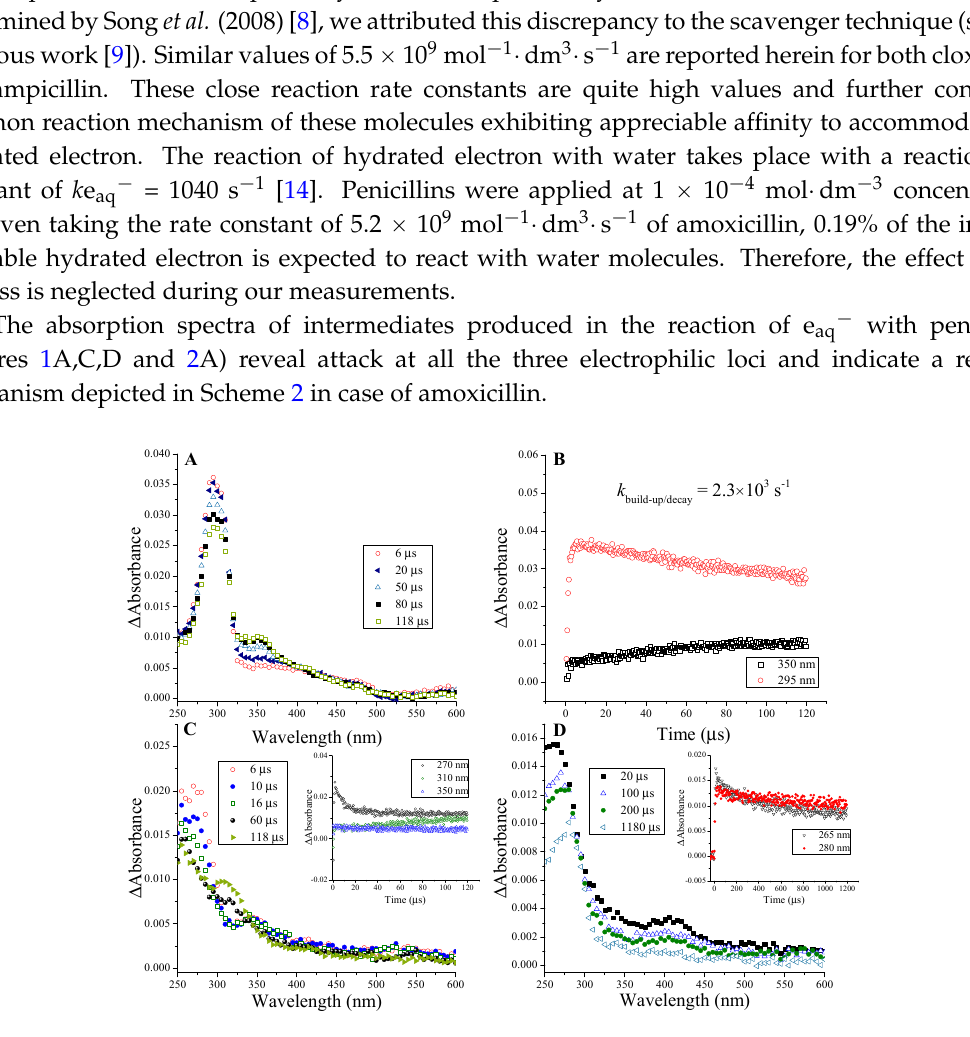
Figure 1. Transient absorption spectra recorded in N 2 -saturated solutions containing 0.5 mol·dm − 3 tert -butanol and 1 × 10 − 4 mol·dm − 3 ampicillin ( A ); cloxacillin ( C ) with inset showing kinetic traces in a solution as specified for ( C ); and 6-aminopenicillanic acid ( D ) with inset showing kinetic traces in a solution as specified for ( D ); Kinetic trace recorded at 350 and 295 nm in N 2 -saturated solution containing 1 × 10 − 4 mol·dm − 3 ampicillin and 0.5 mol·dm − 3 tert -butanol ( B ). Dose/pulse was measured to be 20 Gy in each case.